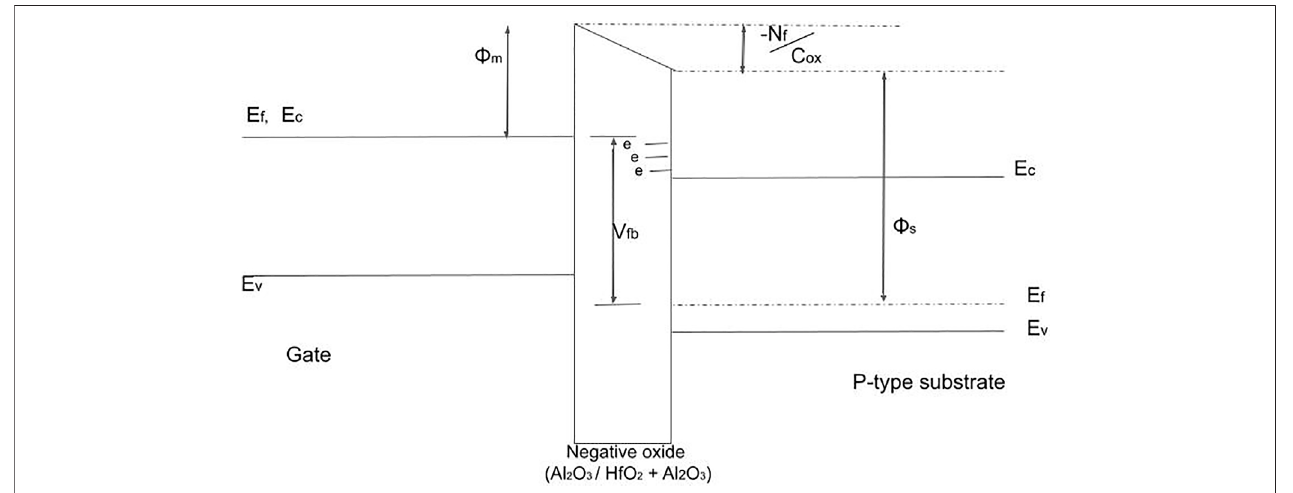
FIGURE 2 | Band diagram showing the fl at-band condition for MOS capacitors with oxide charge in the oxide – silicon interface.